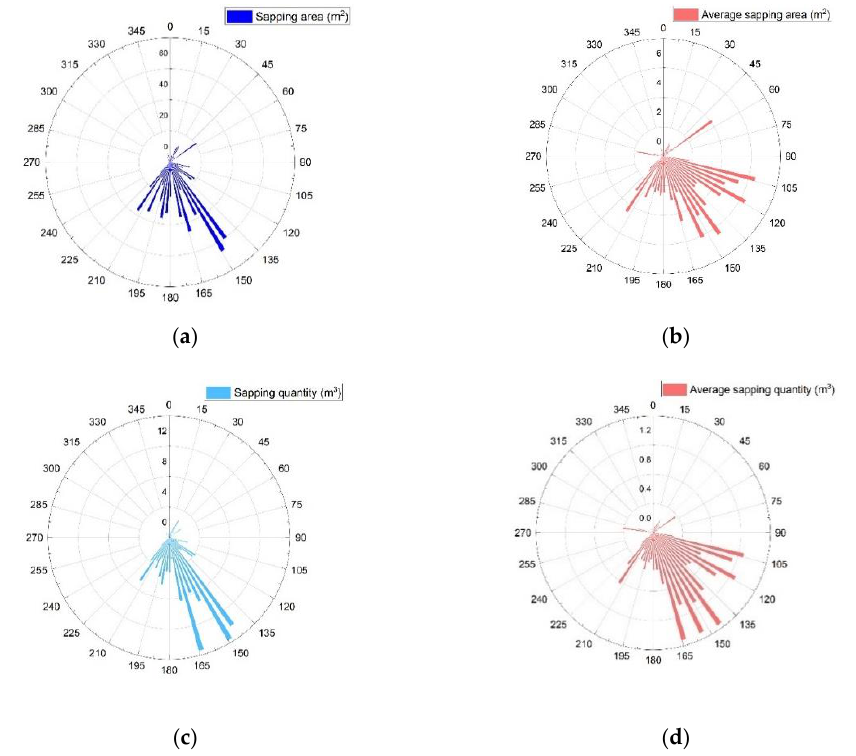
Figure 7. Sapping of the Wall with various azimuth: ( a ) sapping area of the Wall with various azimuth; ( b ) average sapping area of the Wall with various azimuth using 20 m as reference unit; ( c ) sapping quantity of the Wall with various azimuth; ( d ) average sapping quantity of the Wall with various azimuth using 20 m as reference